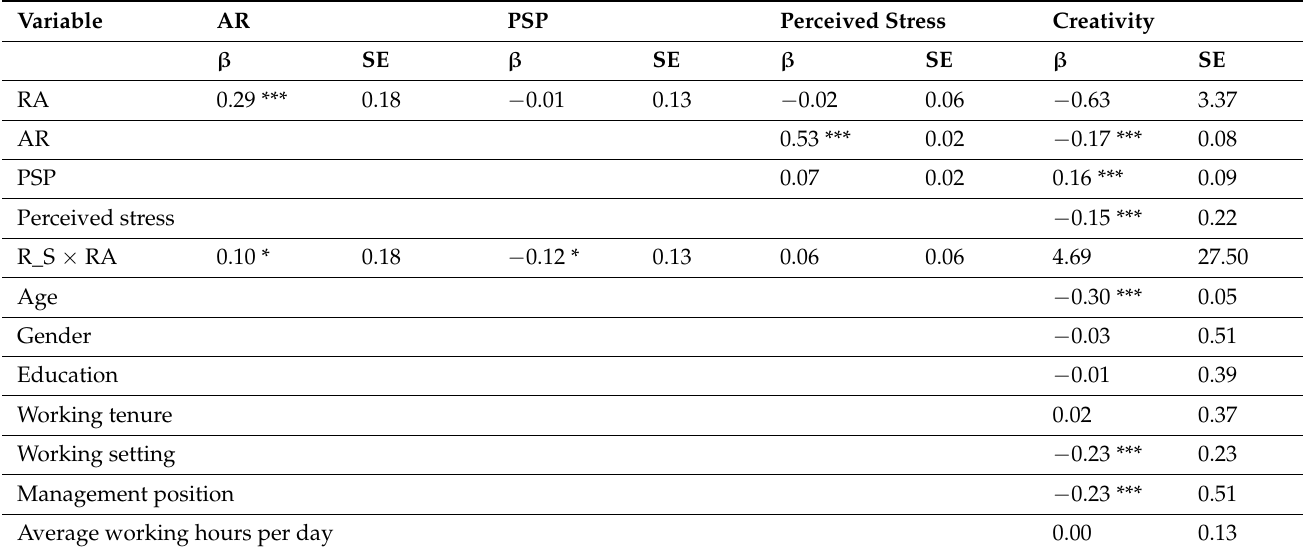
Table 2. Results of multiple regression analyses with creativity as the dependent variable.